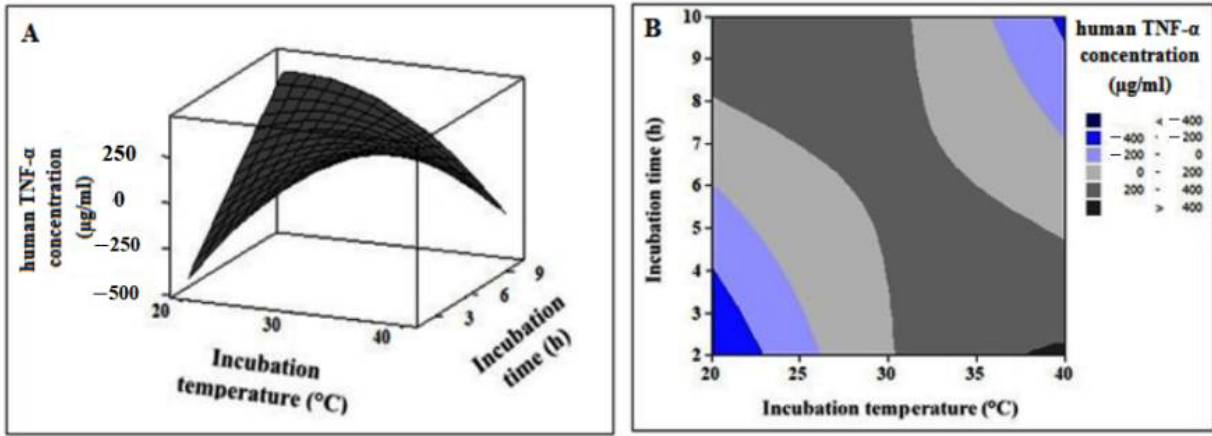
Figure 10. The 3D-surface plot ( A ) and 2D-contour plot ( B ) showing the interactive effect of inde- pendent variables on human TNF-α cell-free synthesis.